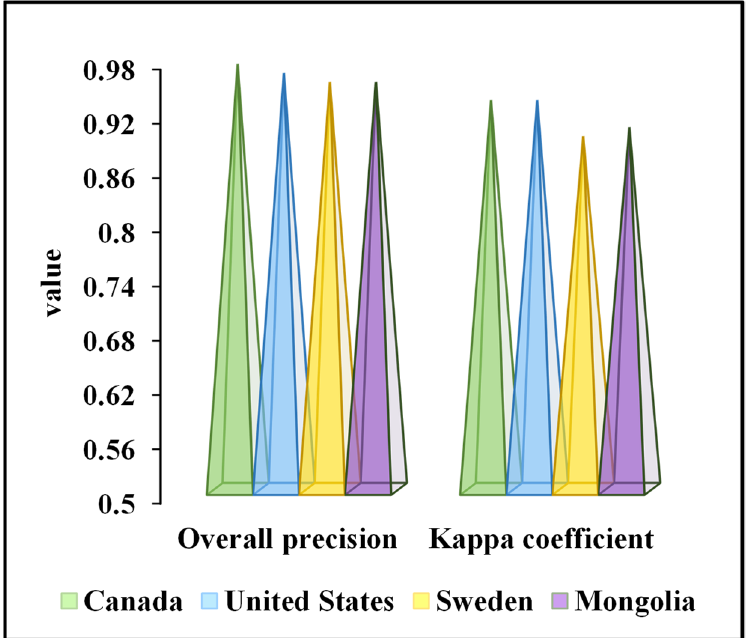
Figure 13. Results of TWI’s kappa coefficient and overall precision at each of the four test sites.